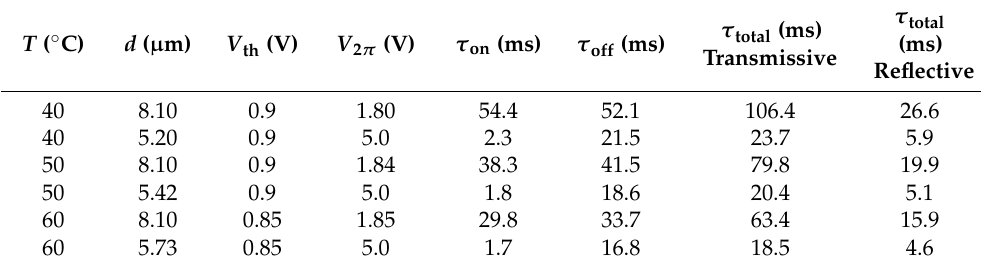
Table 4. Measured response time of a transmissive LCM-2018 cell with d = 8.10 µ m and the extrapo- lated response time to the corresponding reflective cells at 40, 50 and 60 ◦ C with λ = 1550